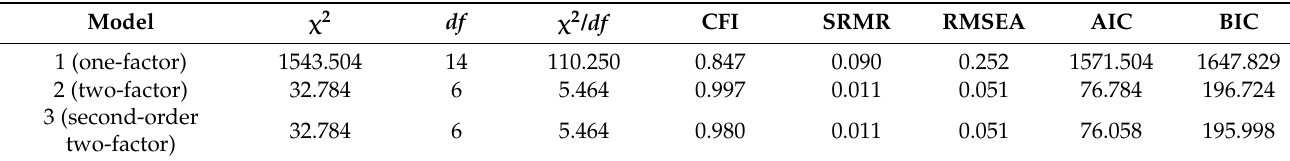
Table 3. Model fit